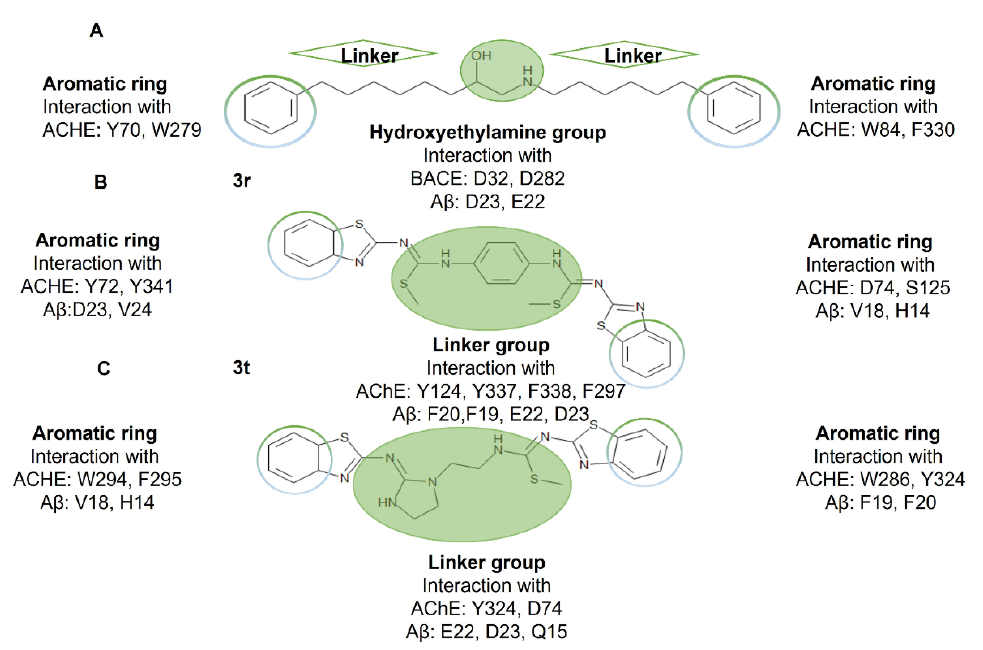
Figure 9. Compound 3r and 3t share chemical characteristics with the pharmacophore proposed to inhibit AChE, BACE1 and as anti-A β 1-42 aggregation. ( A ) The chemical pharmacophore characteris- tics proposed to inhibit AChE, BACE1 and, in addition, the linker could create hydrogen bonds with D23 and E22 of A β 1-42 ; ( B ) compound 3r; and ( C ) 3t had interactions with AChE and A β 1-42 by its aromatic rings and the chemical groups located in the